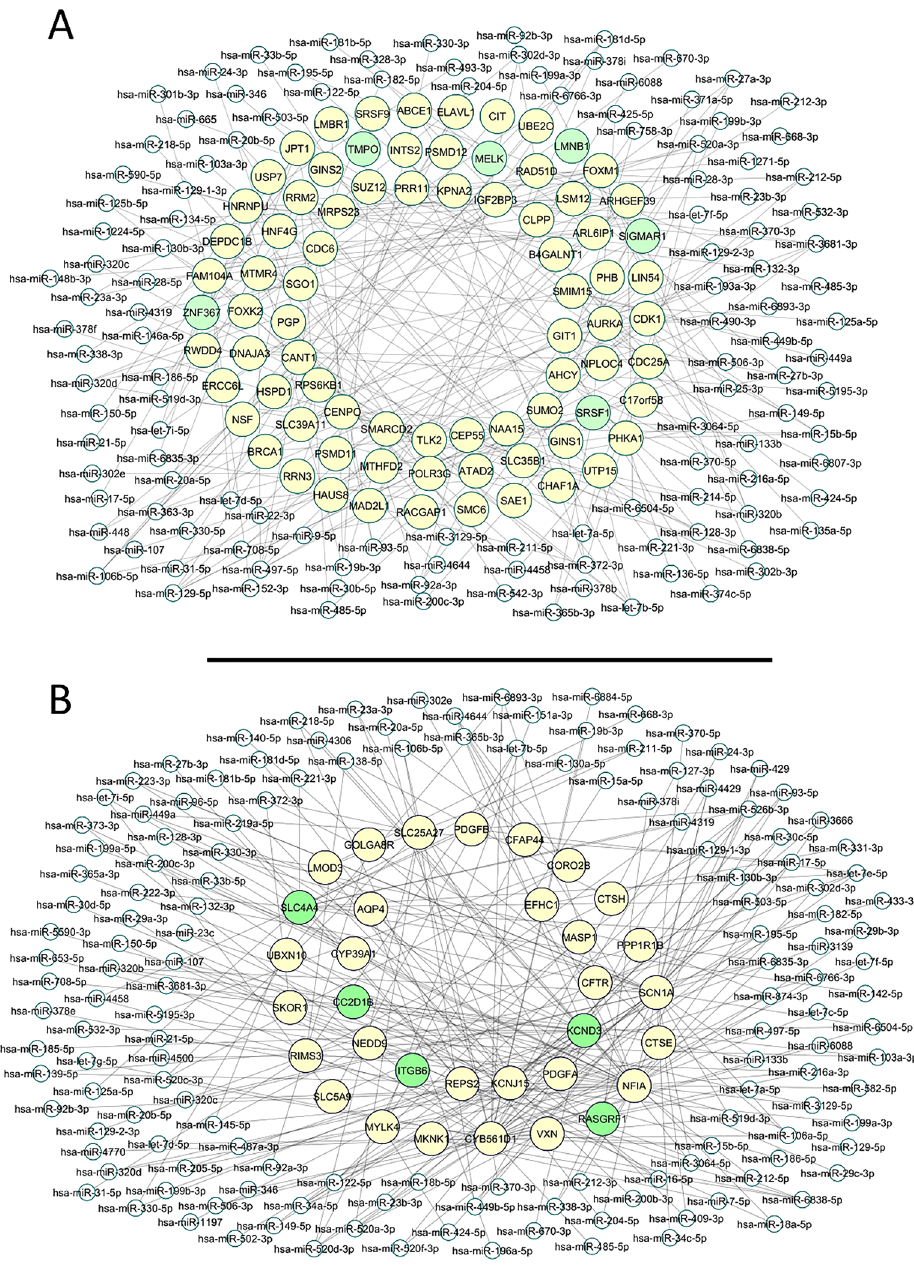
Figure 7. mRNA-miRNA interactions. ( A ) is the overexpressed group interaction, and ( B ) is the down- expressed group. The nodes represent genes, and miRNAs and edges represent interactions. The bigger nodes in the middle of the figure depict mRNAs, while the smaller ones are miRNAs. The light green nodes are survival- related